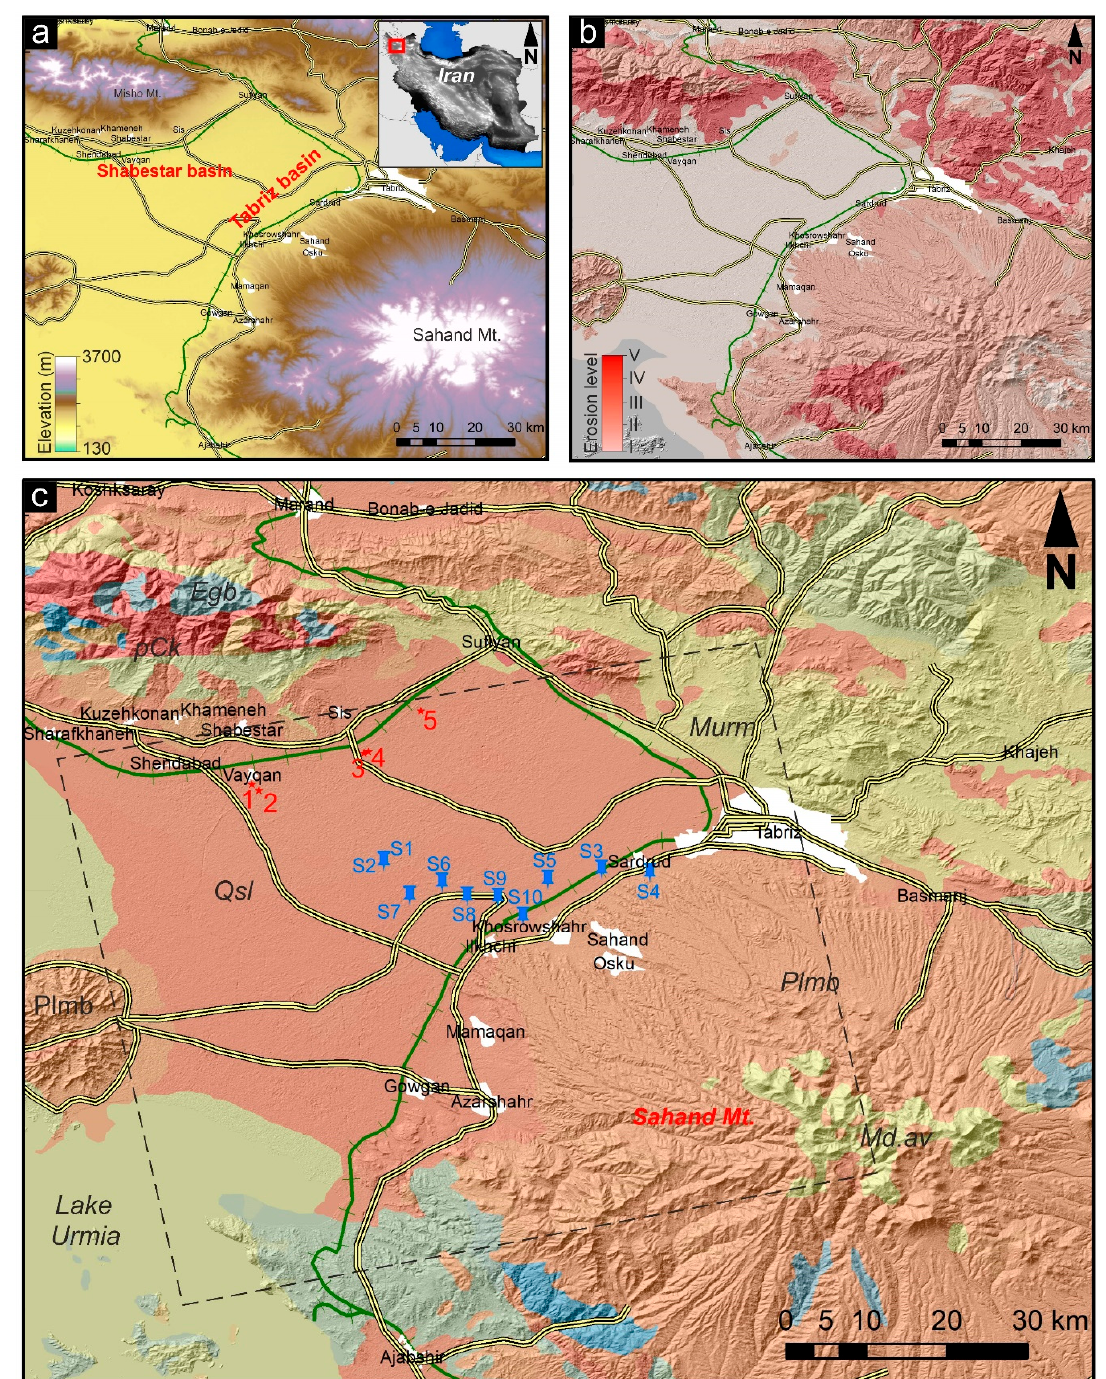
Figure 1. ( a ) Topographic map of study area from Shuttle Radar Topography Mission (SRTM 1 arc-second). ( b ) Erosion map of study area provided by Geological Survey of Iran (GSI) on shaded relief SRTM 1 arc-second. ( c ) Study area with geological units provided by GSI on shaded relief SRTM 1 arc-second. White polygons are cities, red stars and numbers are locations of field observations, blue pushpins are locations of piezometers, dashed square indicates ascending footprint of L-band PALSAR-2 images. Green and thick yellow lines are main railways and roads, respectively. Qsl, Quaternary (unconsolidated sediment); Md.av, dacitic to andecitic subvolcanic rocks; Murm, red to brown marl with gypsiferous marl with sandstone; Plmb, pyroclastic and claystone with vertebrate fauna remains; pCk, dull green-gray salty shales; Plmb, ash-flows; Egb, gabbro rock.